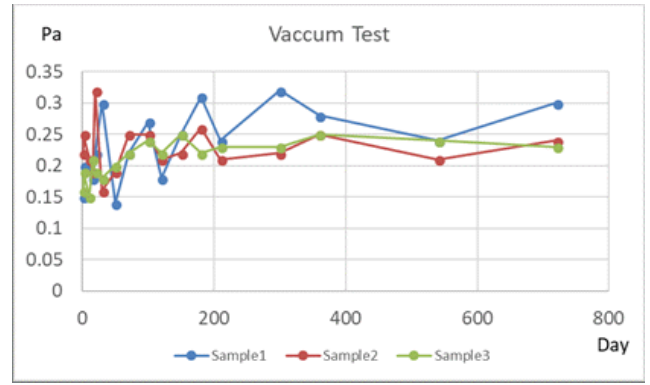
Figure 13. Vacuum tests of the MEMS cavity packaged by glass with TGV and a getter.